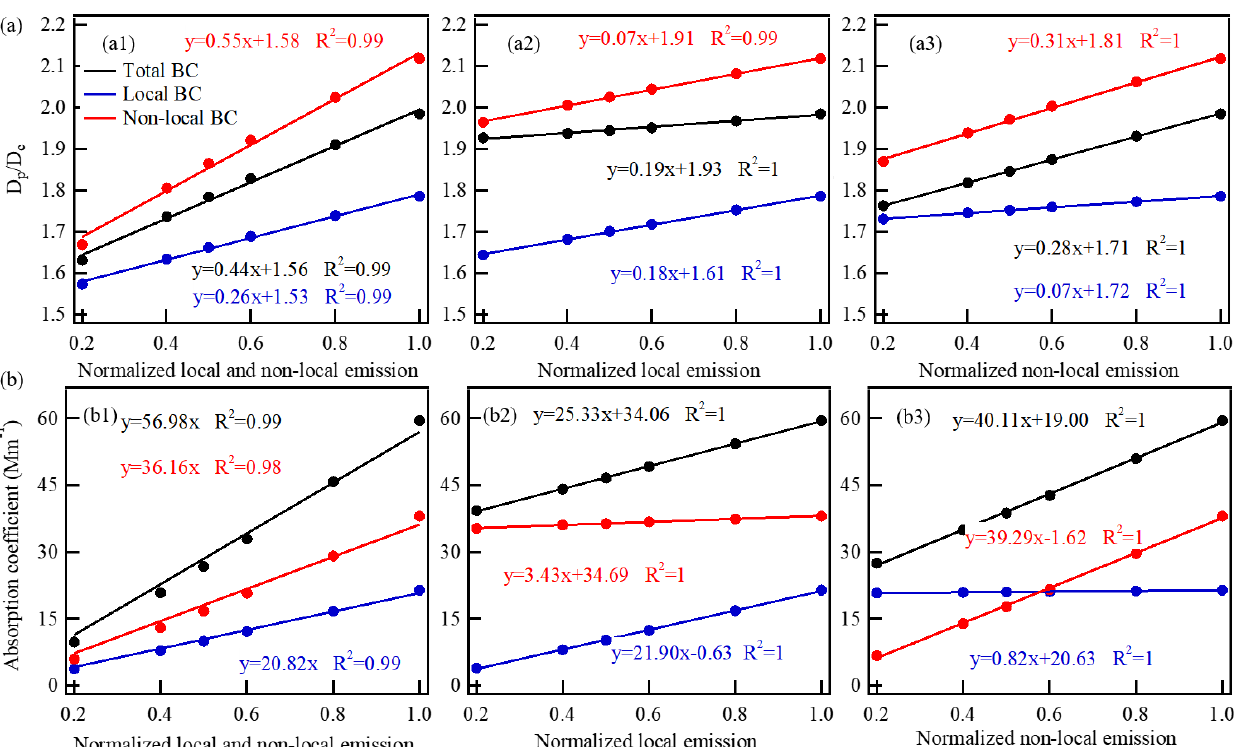
Figure 9. Variations in the (a) D p /D c ratio and (b) light absorption coefficient for total, local and non-local BC over the site with normalized emissions. The current emissions obtained from the MIX inventory (Fig. 2b) were normalized as a unit and the emissions reductions of 20%, 40%, 50%, 60%, and 80% corresponded to the normalized emissions as 0.8, 0.6, 0.5, 0.4, and 0.2, respectively. (a1 ) and (b1) represent the simulations for the case of both local and non-local emission variations, respectively; (a2) and (b2) represent the simulations for the case of only local emissions variations; and (a3) and (b3) represent the simulations for the case of only non-local emissions variations. The light absorption coefficient of BC was estimated by the BC mass concentrations, the mass absorption cross section of BC (7.5m 2 g − 1 at 550nm) and the D p /D c ratio. When the normalized emissions of total BC were equal to 1, the average mass concentration of total BC was ∼ 4.0µgm − 3 , which was obtained by measurements during the campaign period. The mass concentration of local and non-local BC can be further calculated based on their EEI contributions (i.e., ∼ 1.6µgm − 3 for local BC and ∼ 2.4µgm − 3 for non-local BC). Based on the linear decrease in BC mass concentration with emission reduction, the mass concentrations of total, local and non-local BC for different emission cases were